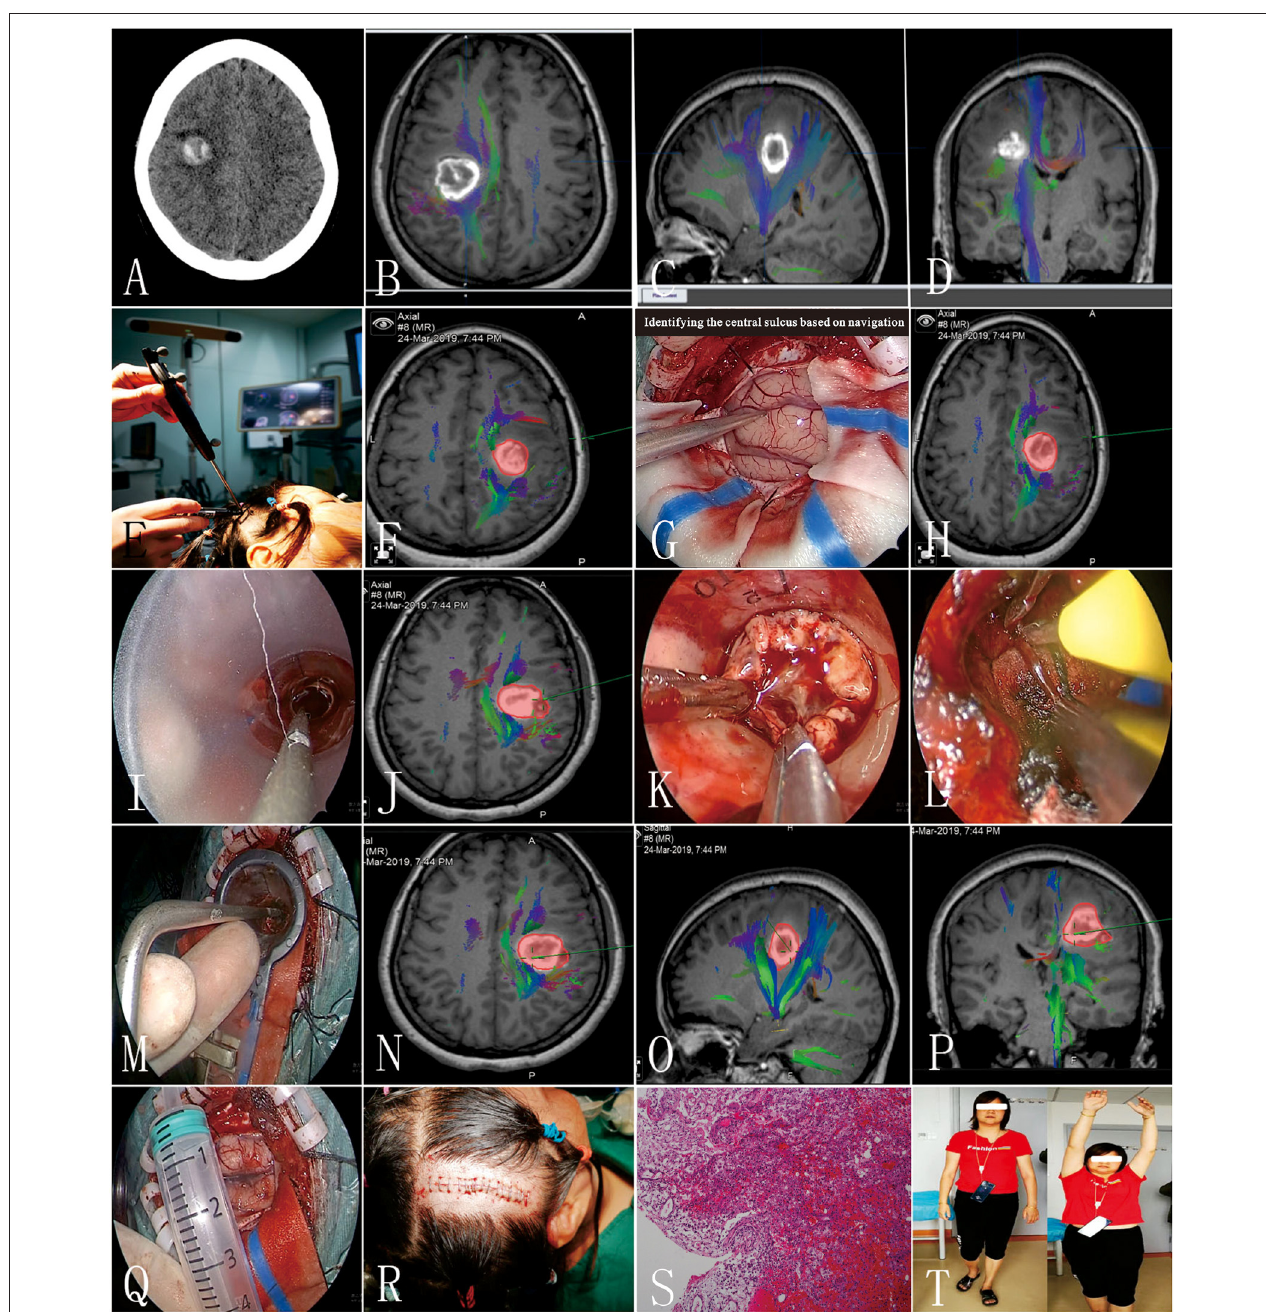
FIGURE 3 | Clinical information of the typical patient (patient 3). (A) Preoperative CT scan; (B–D) preoperative diffusion tensor imaging (DTI) images; (E,F) preoperative navigation to design the incision; (G,H) identifying the central sulcus based on navigation; (I,J) elliptic endoport was inserted under the guidance of a navigation pointer; (K) the yellow-stained surface of the lesion; (L) homeostasis under direct vision; (M–P) identifying the medial border of the lesion; (Q) the width of the bone flap; (R) a small area shaving and a 5-cm linear incision were performed; (S) pathological results; (T) the patient visited the outpatient department 6 months after